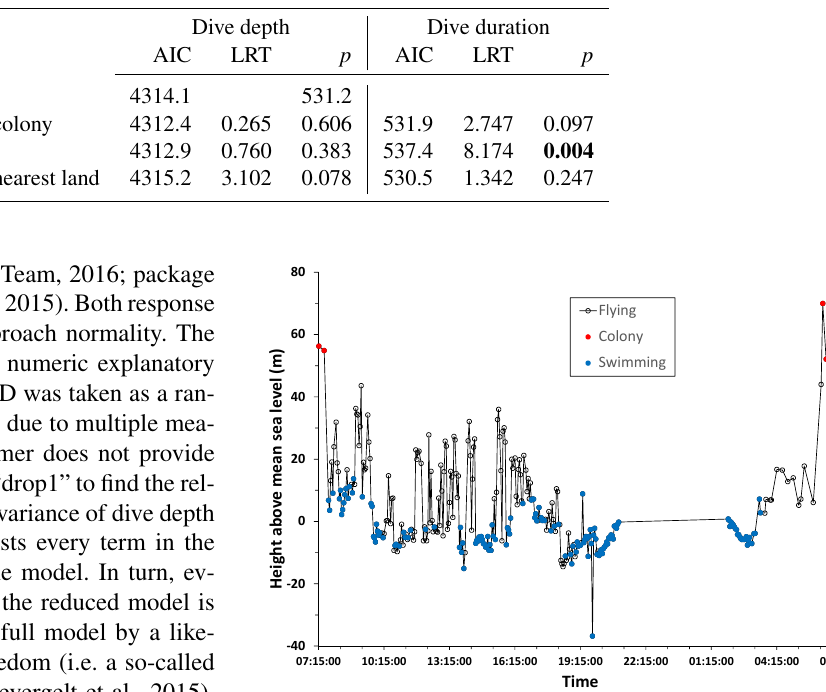
Table 1. Linear mixed model of two key dive parameters (dive depth and dive duration) and their possible explanation by the three fixed habitat variables (distance to colony, water depth, and distance to nearest land). AIC indicates Akaike’s information criterion. LRT indicates the likelihood ratio test. Significant results are shown in bold.